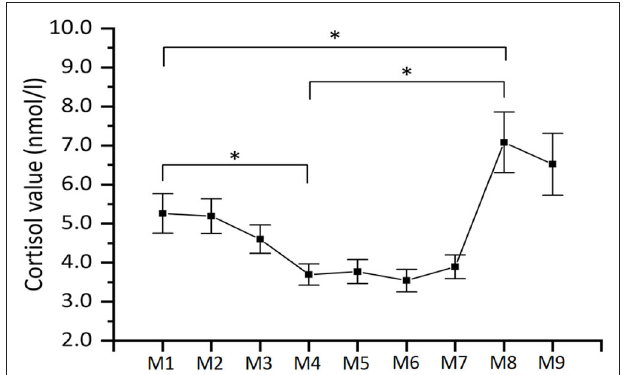
FIGURE 6 | Mean salivary cortisol levels ( n = 45). As explained in the main text, the labels along the x-axis specify the moment of collection of the saliva sample. Note that the time periods between the moments of collection of the saliva sample are not equally distributed over time. Error bars represent ± SE. *indicate statistically significant differences.